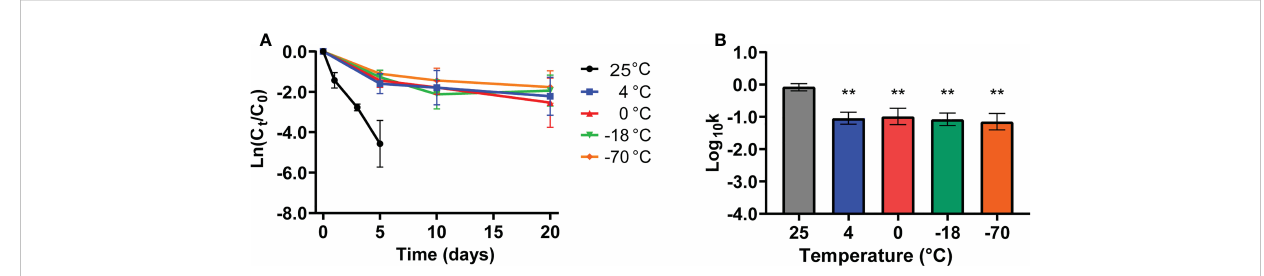
FIGURE 2 The stability of SARS-CoV-2 pseudovirus under cold-chain temperatures. (A) The decay curves of SARS-CoV-2 pseudovirus on PE plastic over 20 days under different temperatures. (B) The decay rate constants k of SARS-CoV-2 pseudovirus on PE plastic under different temperatures. **p <0.01 compared with